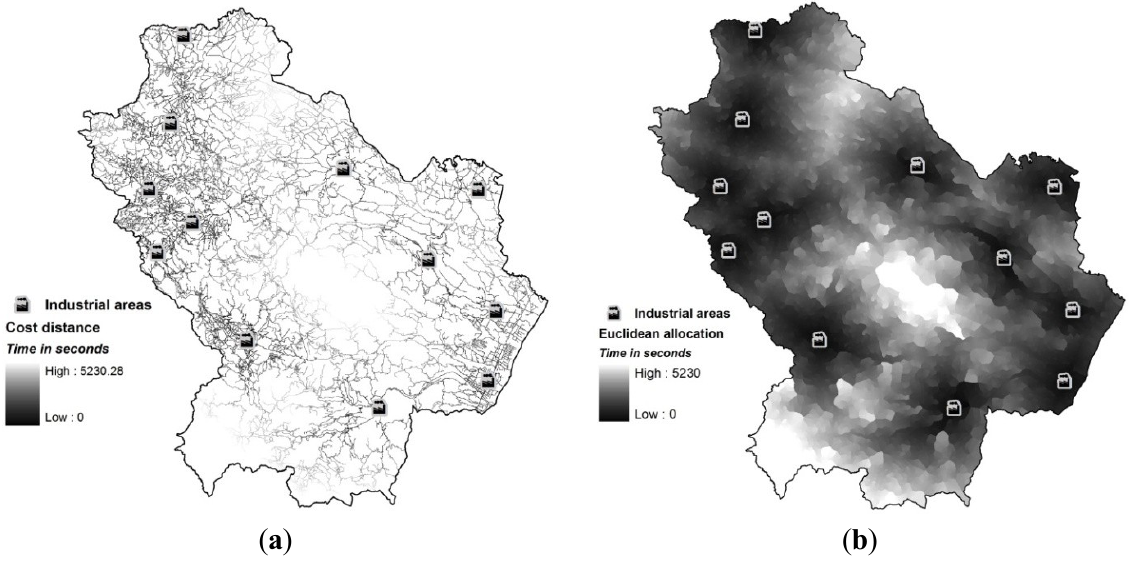
Figure 5. ( a ) Map of the Cost Distance Function. ( b ) Map of the Euclidean Allocation Function.